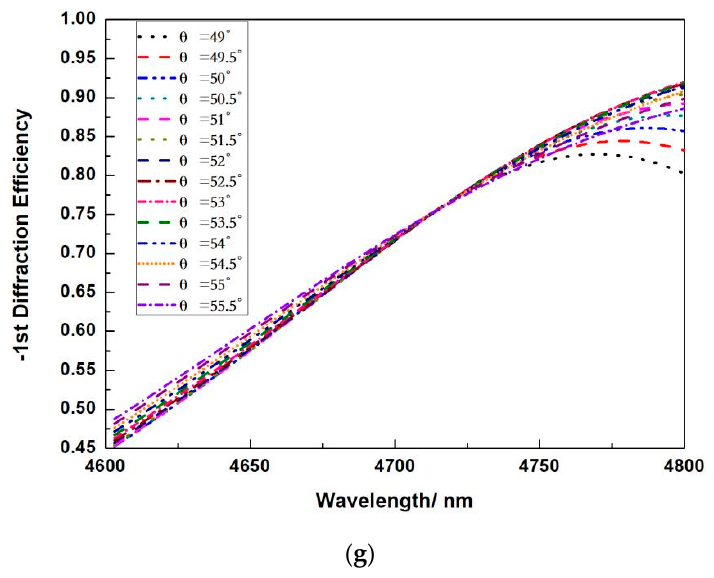
Figure 7. Relationship between the DE versus wavelength at ( a ) ff = 0.35, ( b ) ff = 0.4, ( c ) ff = 0.45, ( d ) ff = 0.5, ( e ) ff = 0.55, ( f ) ff = 0.6, ( g ) ff = 0.65.